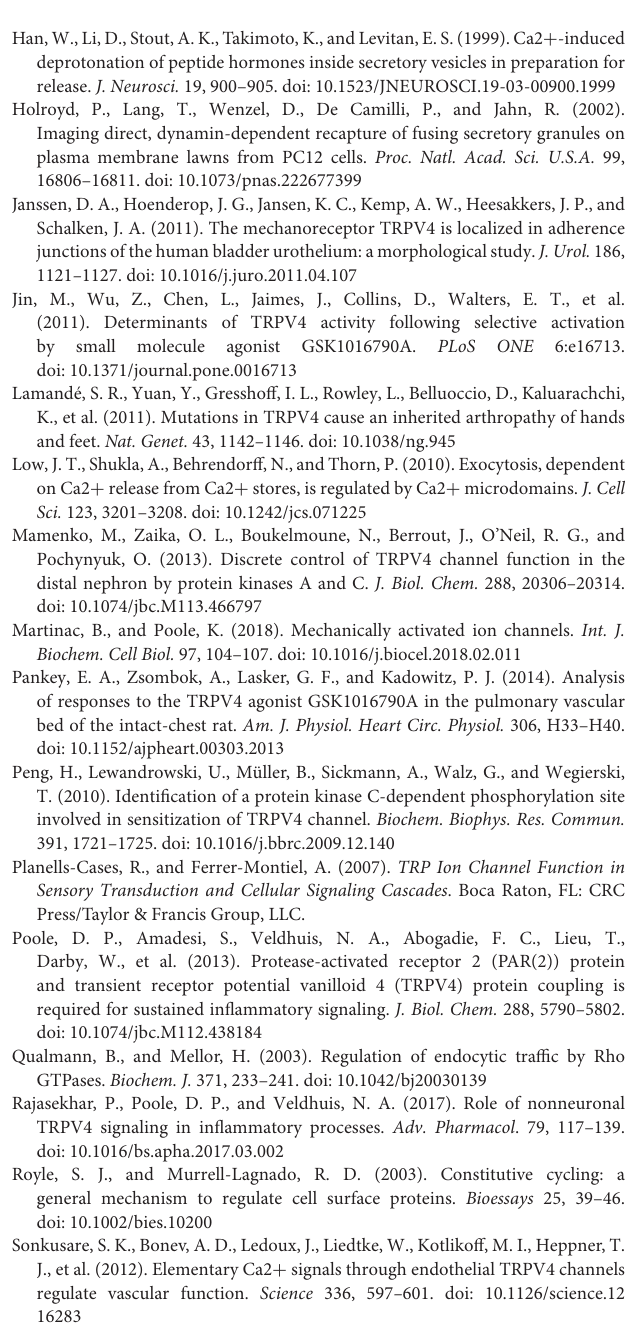
Supplementary Video 2 | TIRF imaging shows two modes of trafficking for TRPV4-Venus molecules, complete and partial fusion (black arrows). Supplementary Video 3 | TIRF imaging of HEK293-TRPV4-Venus cells, control group shows that there is a decrease in the intensity of the TRPV4-Venus fluorescent signal. Supplementary Video 4 | TIRF imaging of HEK293-TRPV4-Venus cells treated with GSK1016790A (GSK101) shows that there is a decrease in the intensity of the TRPV4-Venus fluorescent signal.